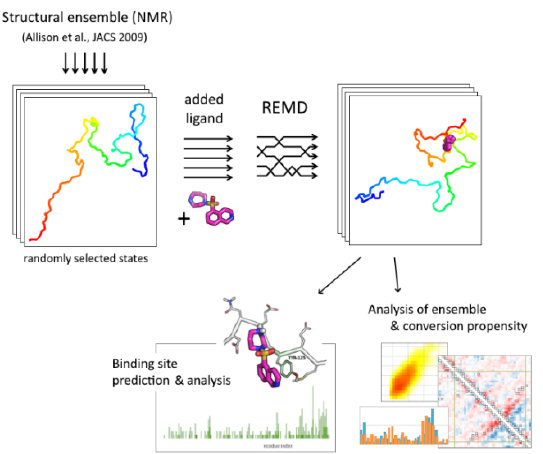
Figure 5. The scheme of the REMD-based docking pipeline.